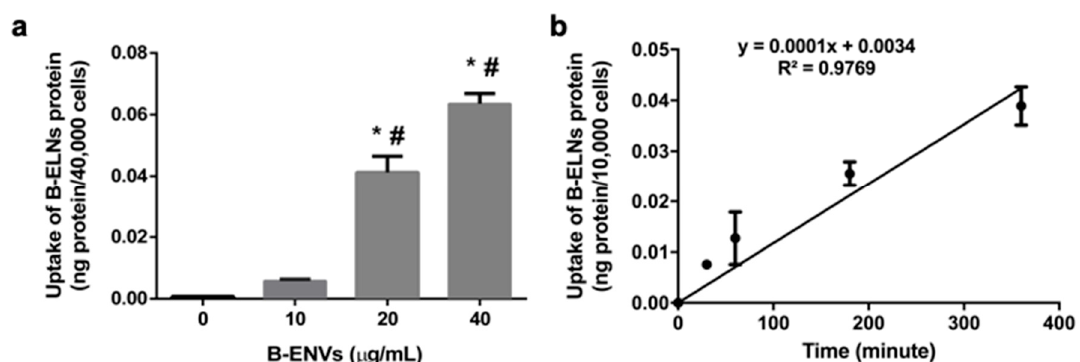
Figure 2. ( a ) B-ELNs uptake into human stabilized endothelial cell line (EA.hy926 cells) as a function of dose 0-40 μ g/mL proteins at 37 °C for 3 h. (n = 3). ( b ) B-ELNs uptake into EA.hy926 cells as a function of time at a concentration of 20 μ g/ μ L and a temperature of 37 °C (n = 3). Values are means ± SD of three separate experiments. * p < 0.05 vs control, #0.05 vs B-ELNs 10 μ g/ μ L.